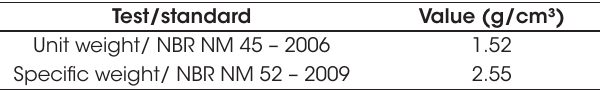
Chemical characterization of the rice husk ash used